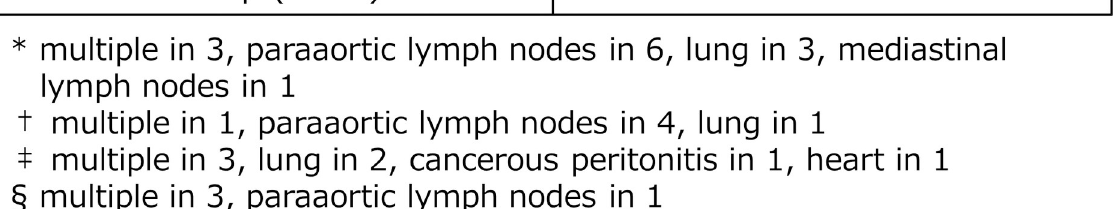
Fig 1. Patient disposition and clinical outcome. Of 148 enrolled, 3 were excluded before starting the treatment, 1 could not complete definitive radiotherapy, and two transferred to another hospital with less than 1 year of observation. Of 142 analyzed, 98 were alive with no evidence of disease, 23 were alive with progression of disease, 18 were dead, and 3 were lost to follow-up during the observation period.